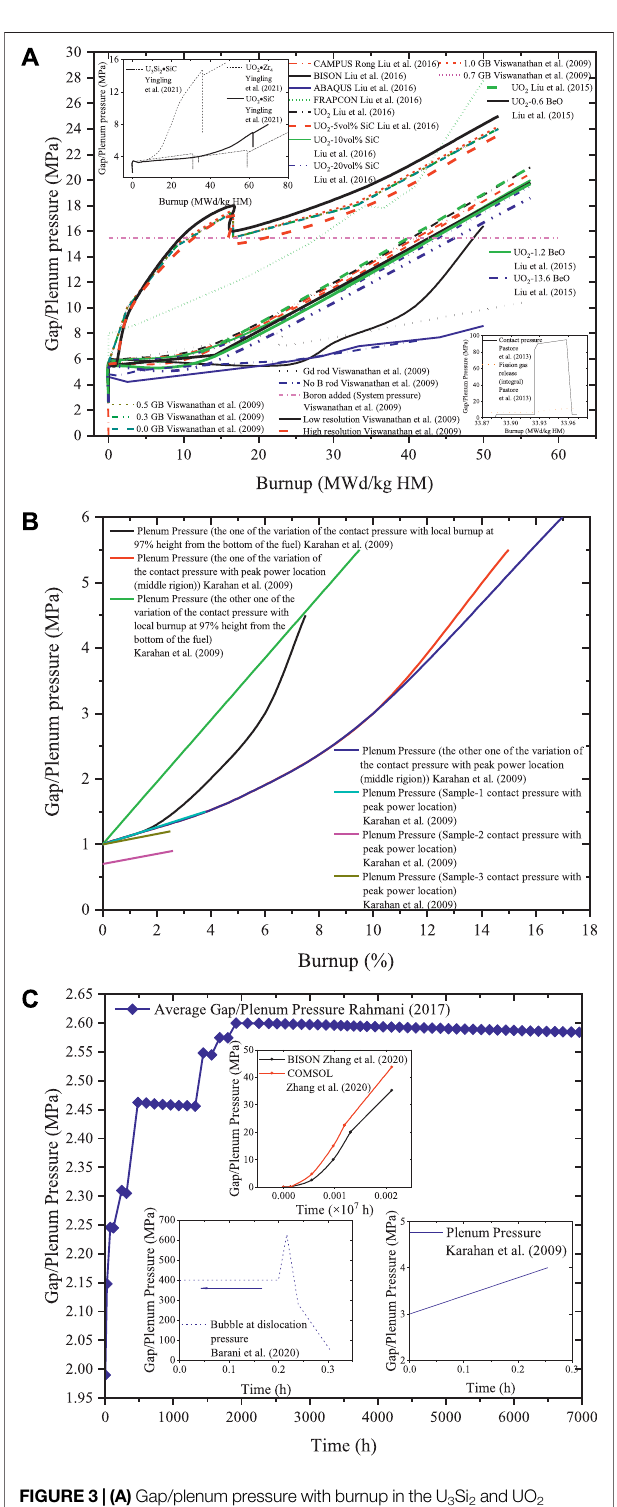
FIGURE 3 | (A) Gap/plenum pressure with burnup in the U 3 Si 2 and UO 2 fuels (Viswanathan et al., 2009; Pastore et al., 2013; Liu et al., 2015; Liu et al., 2016; Yingling et al., 2021). (B) Gap/plenum pressure with burnup in the metallicfuel(Karahanetal.,2009). (C) Gap/plenum pressurewithtime in the TRISO, metallic, and UO 2 fuels (Karahan et al., 2009; Rahmani, 2017; Barani et al., 2020; Zhang et al., 2020).